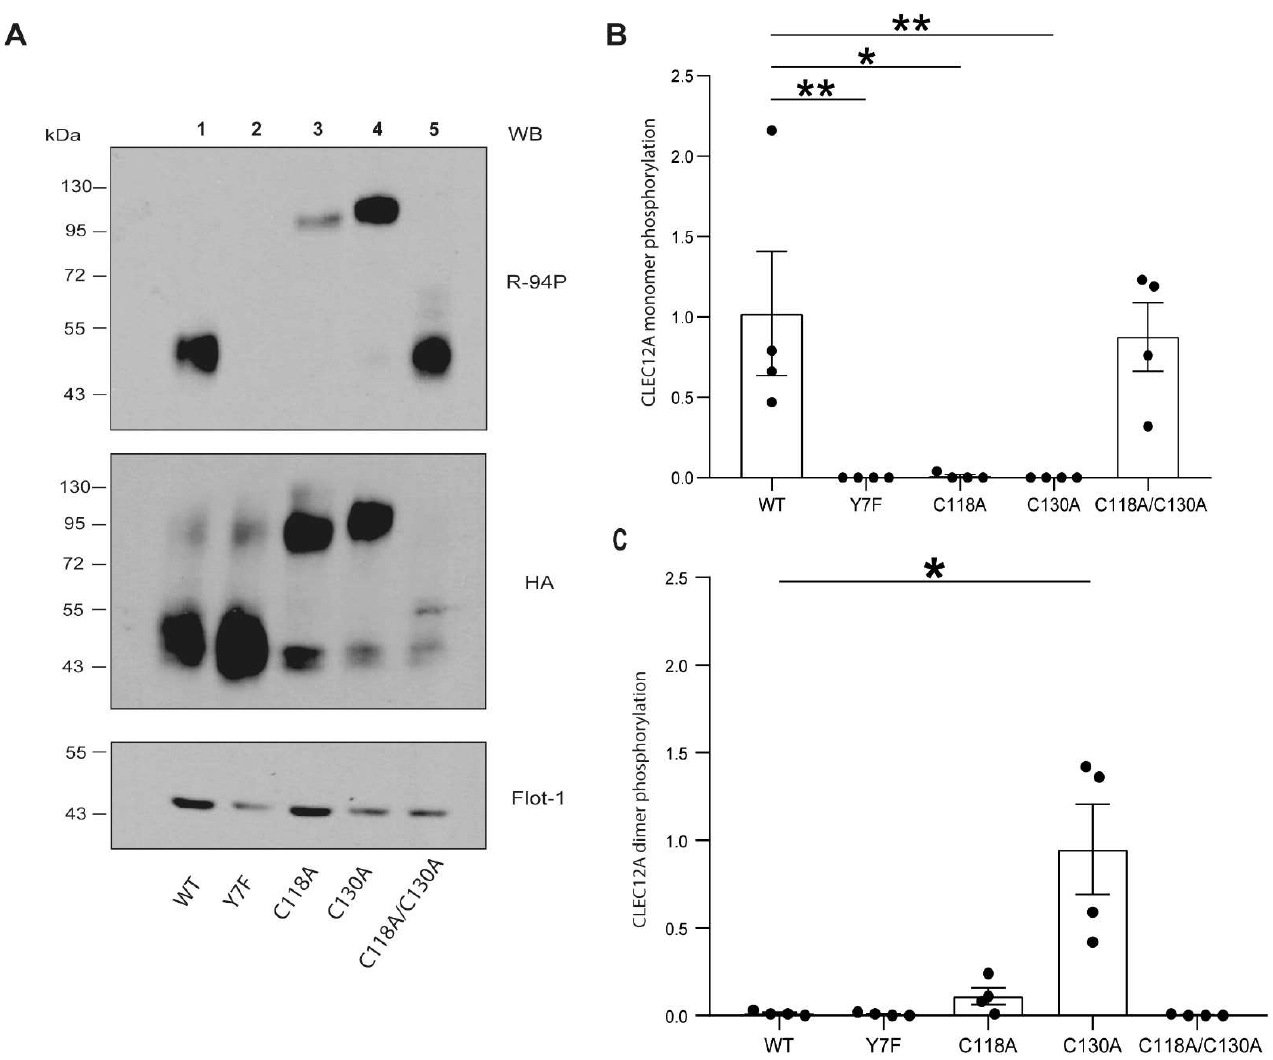
Figure 3. C118 and C130 mutants are phosphorylated. ( A ) CLEC12A phosphorylation was analyzed by Western blot with the R-94P antibody, the anti-HA antibody and the anti-Flotillin-1 (loading control) in HEK-293T cells transiently expressing the indicated CLEC12A constructs and treated with pervanadate. ( B , C ) Densitometry analysis of the phosphorylated monomer and dimer forms of WT and mutant CLEC12A. These data are representative of 4 independent experiments. Statistical analysis: Kruskal-Wallis, uncorrected Dunn’s test * p < 0.05; ** p < 0.01.